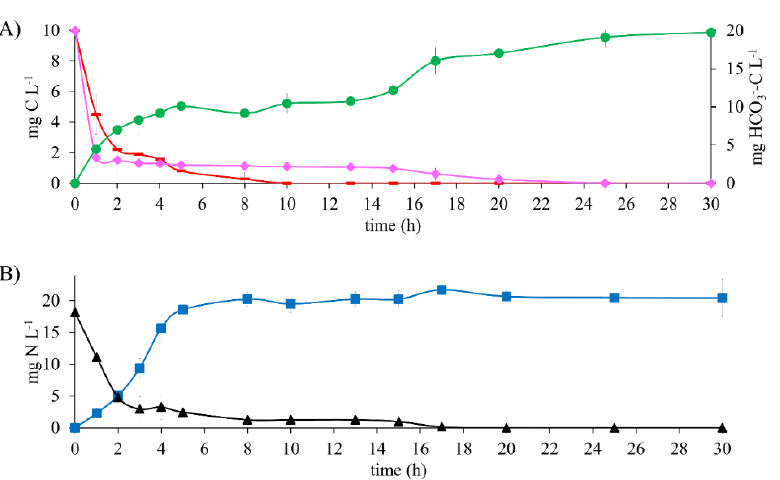
Figure 4. Kinetic profile of denitrifying assays with 10 mg E2-C L − 1 in a mixture containing 10 mg CH 3 COO − -C L − 1 at C N − 1 of 1.1. ( A ) Carbon compounds: ( ♦ ) E2-C, ( ▬ ) CH 3 COO − -C, ( ● ) HCO 3 − -C (secondary axis). ( B ) Nitrogen compounds: ( ■ ) N 2 , ( ▲ ) NO 3 − -N.